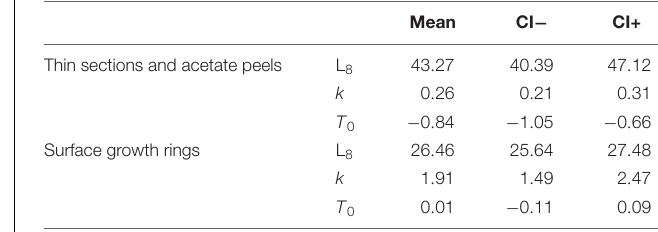
TABLE 3 | Mean VBF growth curves parameters and respective CIs assessed by the model for Chamelea gallina from the mid-western Adriatic Sea using the three aging